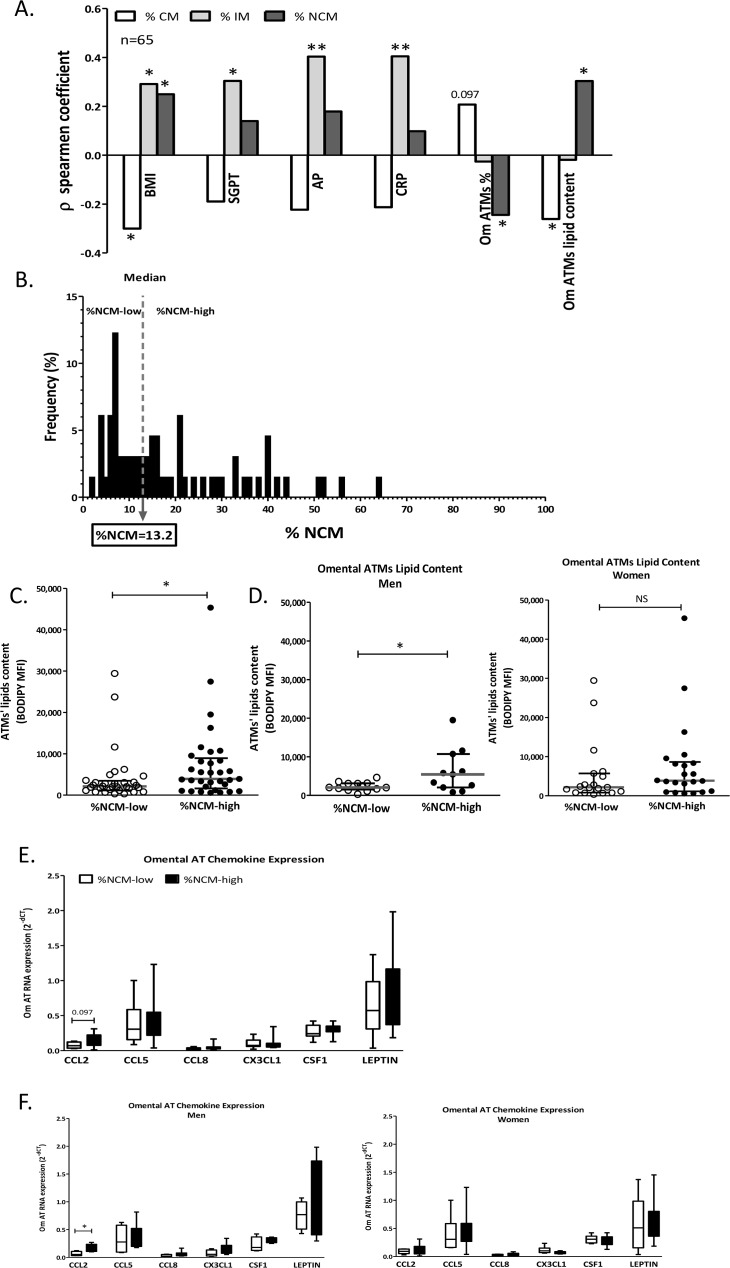
Monocyte subclasses association with clinical and adipose tissue parameters.A) Spearman Correlation analysis between clinical parameters and omental adipose tissue parameter and % circulating monocyte subclass (CM-classical monocytes; IM-intermediate monocytes; NCM-non-classical monocytes). B) Distribution of the patients' cohort to %NCM-low and–high according to the median value (13.2%). Omental ATM lipid content was compared between %NCM-low and %NCM-high C) in the whole cohort (n = 32 vs. n = 33, respectively), or separately D) in men (left graph, n = 13 vs. n = 11, respectively) and in women (right graph, n = 19 vs. n = 22, respectively). Adipose tissue chemokine expression was compared between %NCM-low and %NCM-high E) in the whole cohort (n = 11 vs. n = 15, respectively), or separately F) in men (left graph, n = 4 vs. n = 6, respectively) and in women (right graph, n = 7 vs. n = 9, respectively). Statistical comparison was obtained by the Mann-Whitney U test. *p< 0.05, **p<0.01.